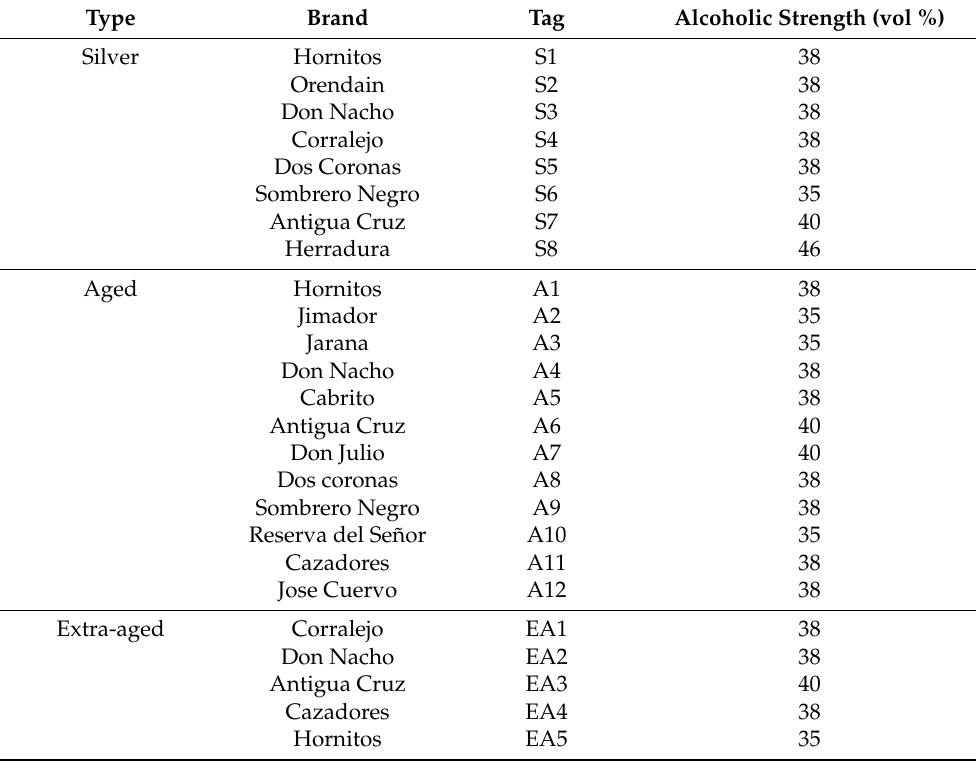
Table 1. Tequila samples under study grouped by